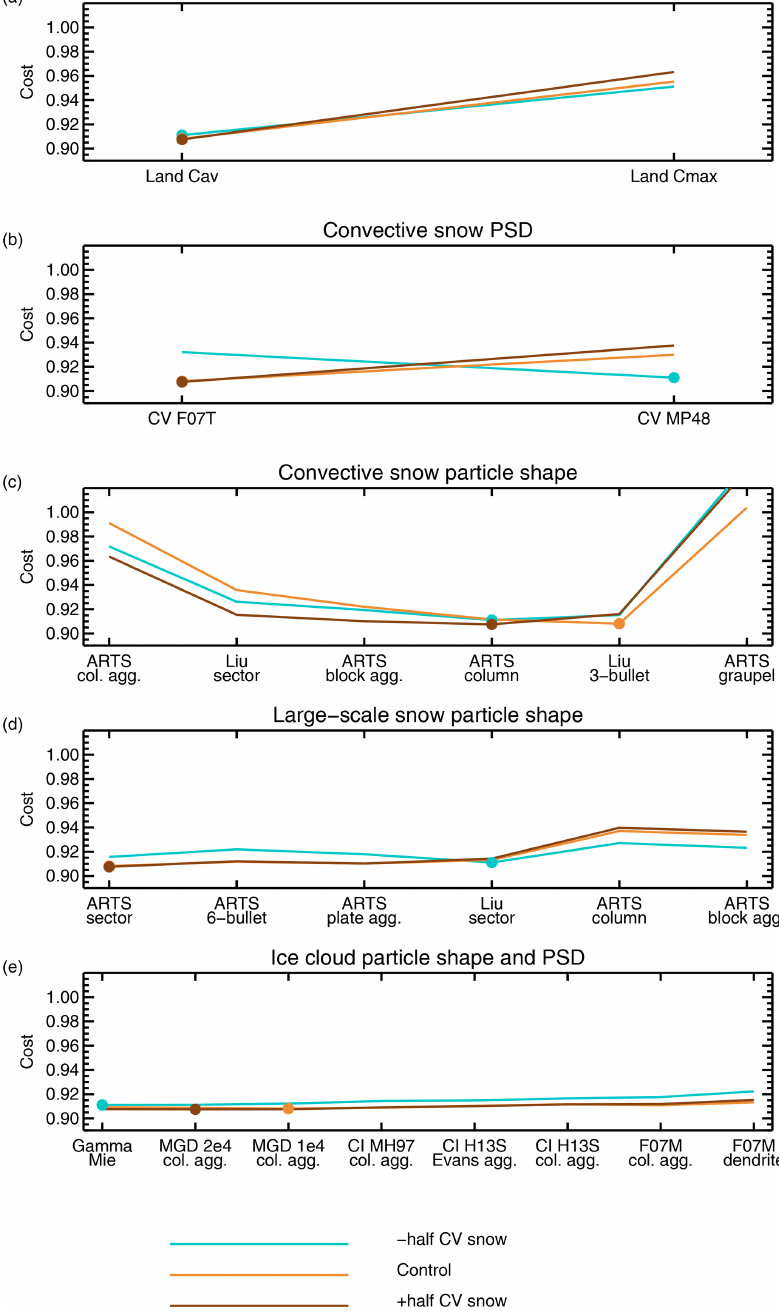
Figure 10. Slices through the six-dimensional cost function around the best configuration when the convective mixing ratio is prescribed at − 50%, control, or + 50%. The + 50% lines are the same as the best solution in Fig.